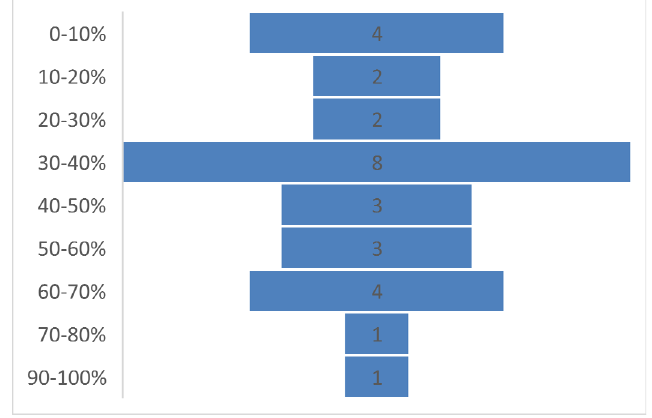
Figure 4. The number of countries at each implementation level.